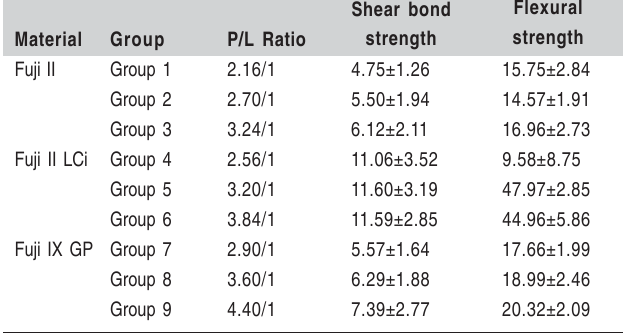
Flexural Shear bond strength